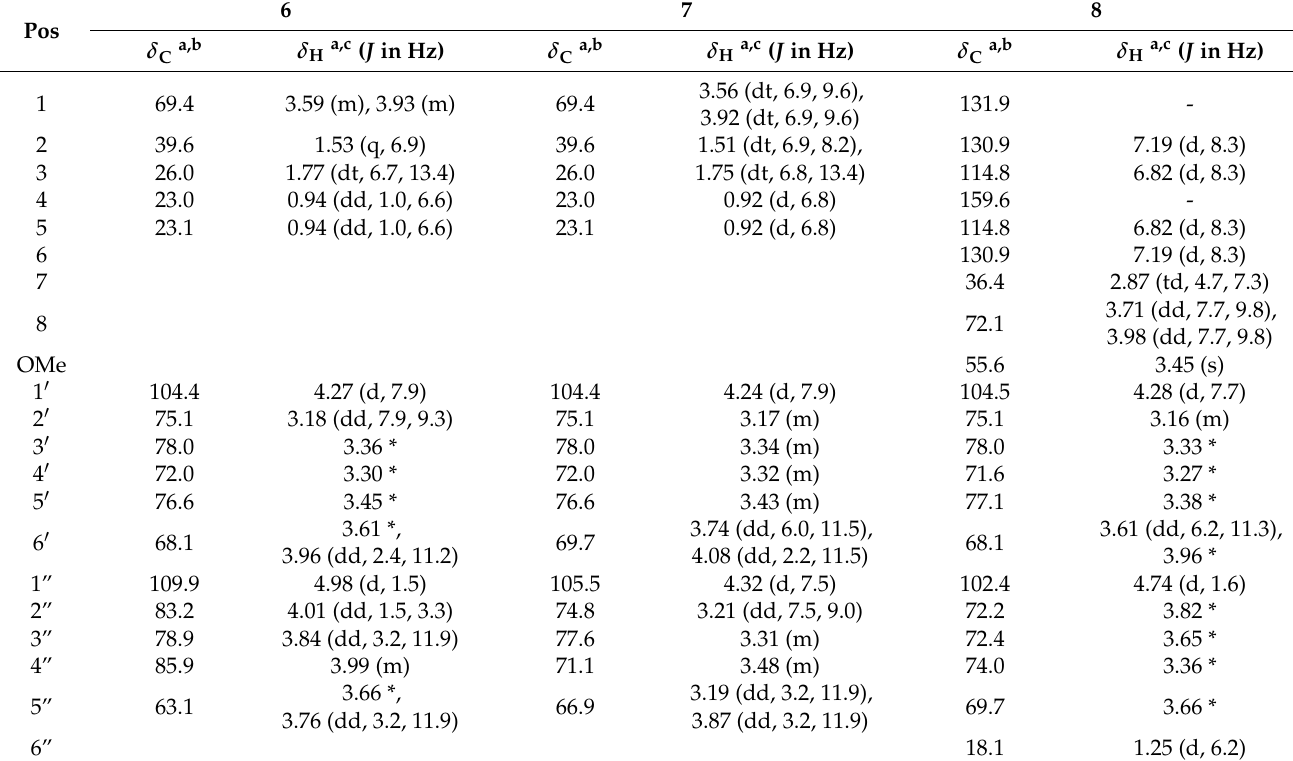
Table 2. NMR spectroscopic data for compounds 6 – 8